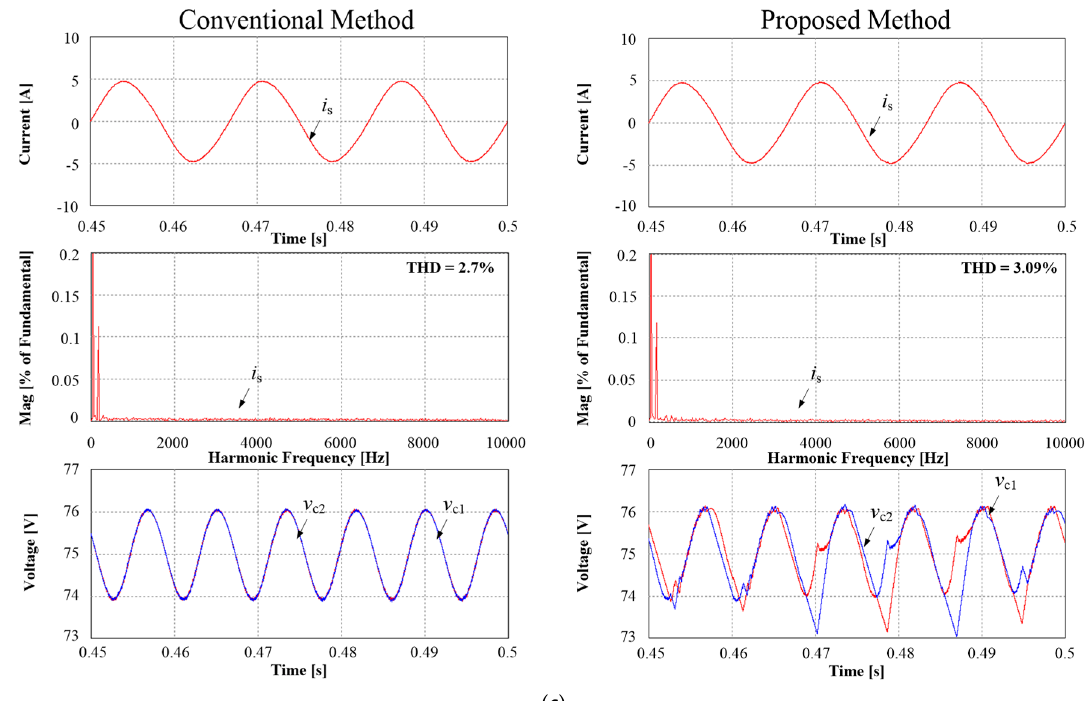
Figure 16. Simulation results of ac source current ( i s ), frequency spectrum of input current ( i s ), and capacitor voltages ( v aN, v bN ) obtained by the conventional and the proposed methods with input parameters ( a ) R s = 1 Ω and L s = 10 mH ( b ) R s = 2 Ω and L s = 20 mH, and ( c ) R s = 3 Ω and L s = 30 mH.